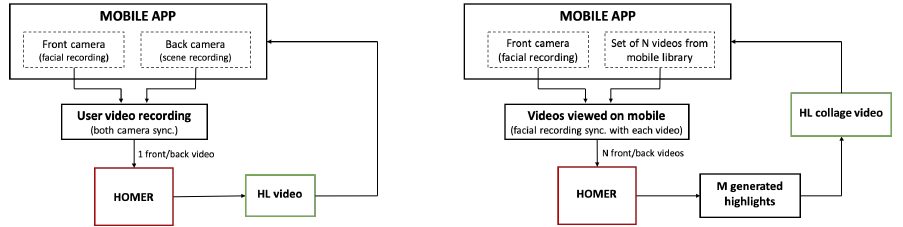
Figure 14. Block-diagrams of Application 1 ( left ) and Application 2 ( right ).